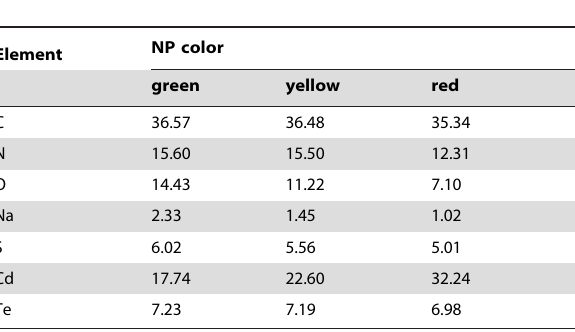
Table 1. EDS elemental analysis of the as-prepared CdTe-GSH NPs. The element per cent in green, yellow and red CdTe-GSH NPs was determined.